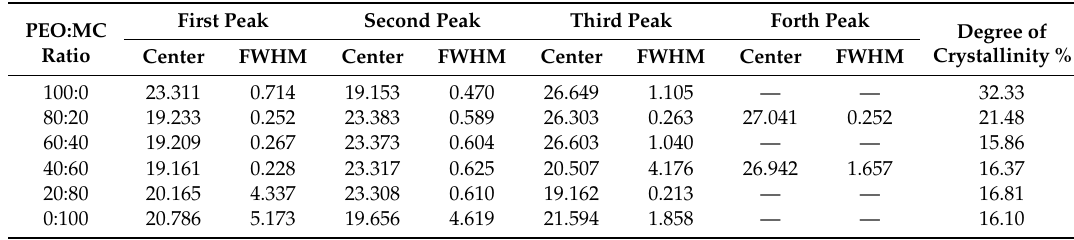
Figure 2. Deconvoluted XRD peaks for different concentrations of PEO:MC polymer blend. The inner graph depicts the peaks for the crystalline region, while the outer shows the peaks for both the crystalline and amorphous regions (dotted lines represent the sum of Gaussian peaks). Table 1. Center, full width half maximum (FWHM) of the deconvoluted XRD peaks, and degree of crystallinity for PEO:MC polymer blend films with different compositions.